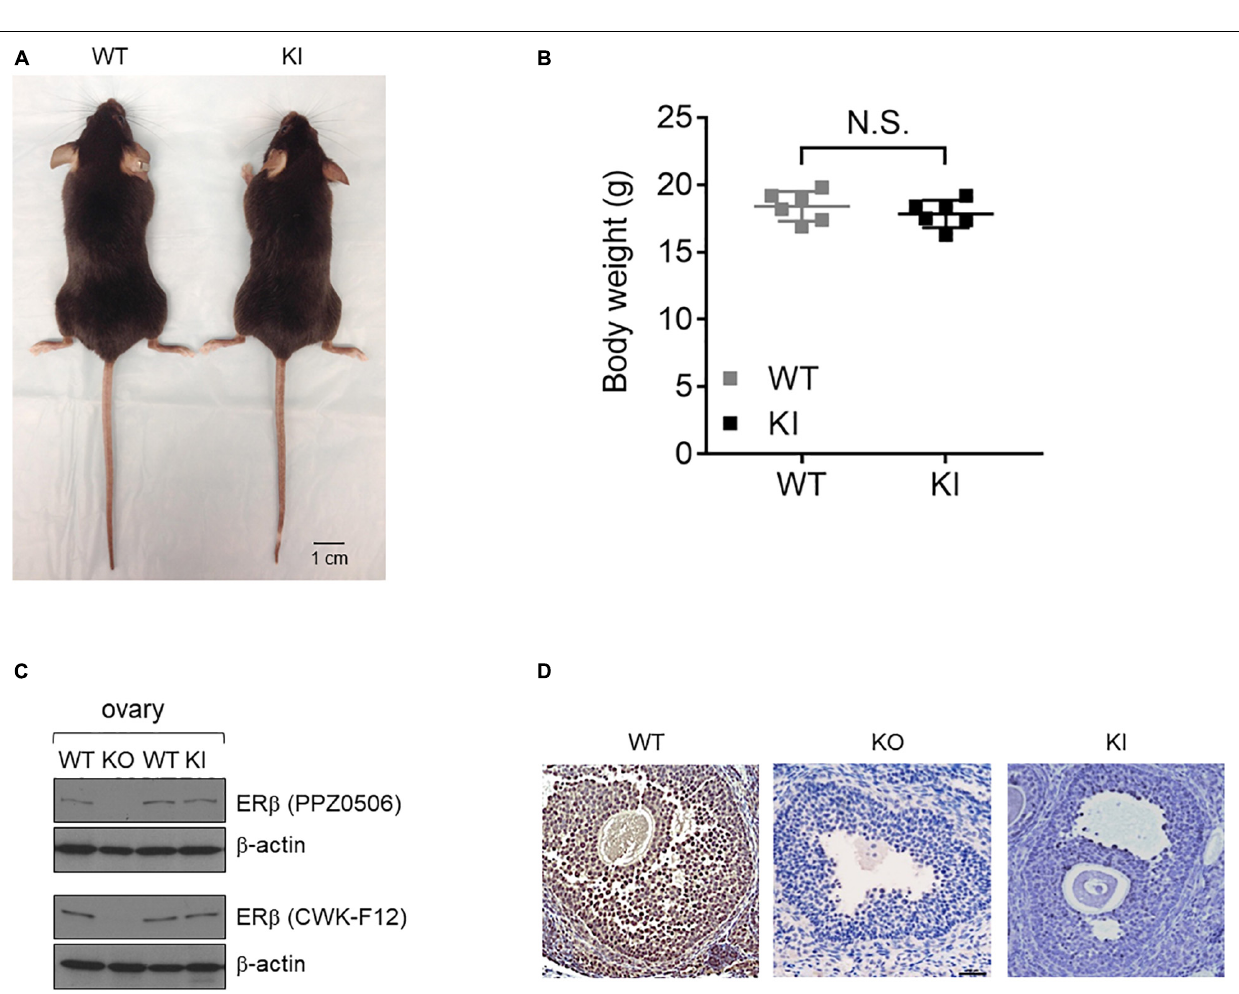
FIGURE 1 | Generation and validation of the Esr2 Y55F KI animal model. (A) The gross appearances of KI (right) and WT (left) female mice at 8 weeks of age. Scale bar, 1 cm. (B) WT and KI female mice body weight at 8-week old. Results are presented as mean ± SEM. n = 6; N.S.: Not Significant, Student’s t -test. (C) Western blot analysis of ovarian tissue extracts from ER β KO, Y55F KI, and WT littermates. Two different commercial anti-ER β antibodies were used. (D) Representative images of immunohistochemical staining for ER β pY55 in the ovaries from WT, ER β KO, and Y55F KI mice ( n = 6 per genotype). Scale bar, 100 µ